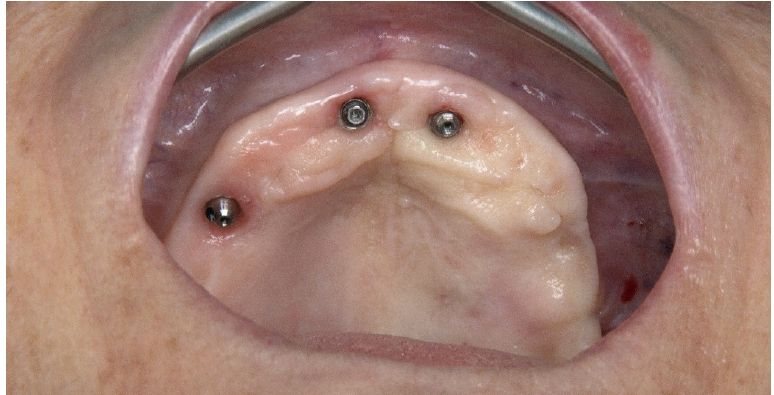
Figure 19. Preoperative orthopantomography of the maxilla missing the posterior tilted implant on the 3rd sextant.